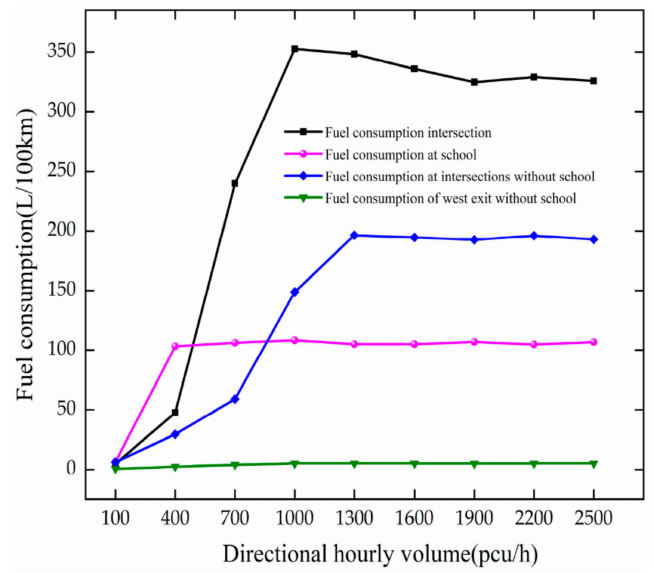
Figure 10. Variation trend of fuel consumption with